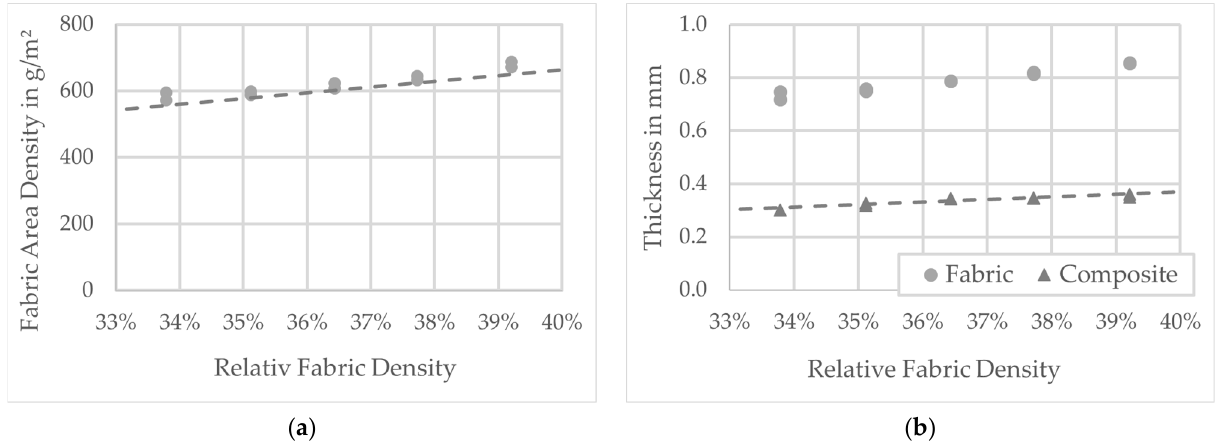
Figure 12. Results of the fabric testing for various weft yarn densities: ( a ) fabric area density and calculation result as trendline; ( b ) fabric and composite thickness with calculation result as the trendline.